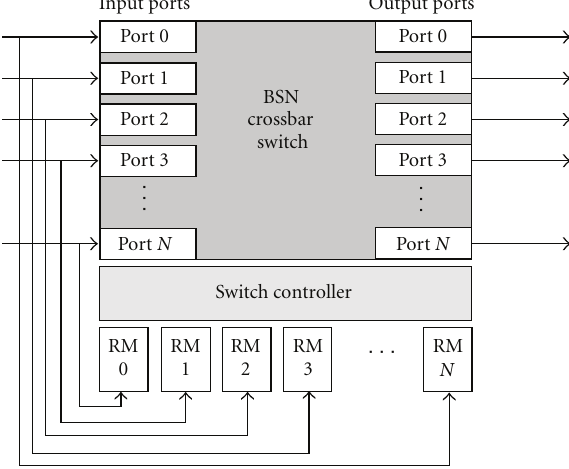
Figure 6: Block switch network’s router consisting of a full crossbar switch, routing modules per each input port, and a single switch controller used to configure the inputs to the requested